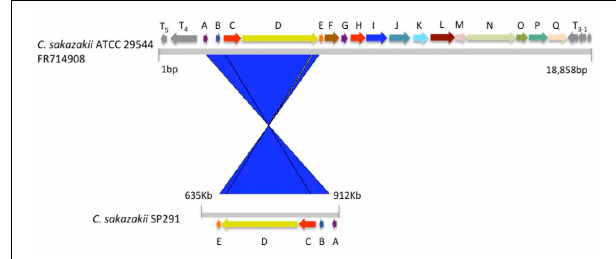
FIGURE 3 | The putative thermotolerance-containing DNA region of C. sakazakii ATCC 29544 compared with C. sakazakii SP291.